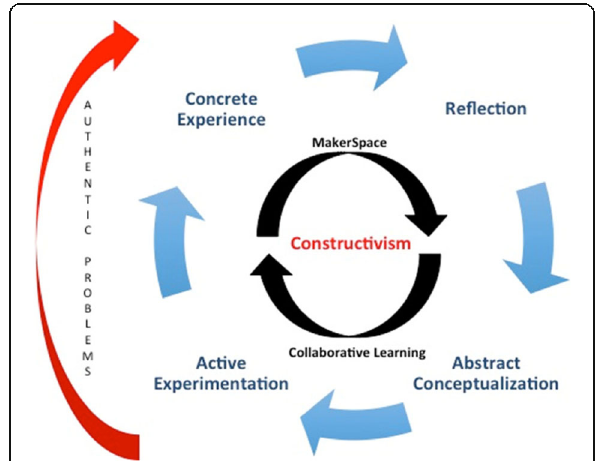
Fig. 1 A conceptual model of the relationship between the instructional theory, instructional strategies, and instructional framework for the course that led to the research of assessment of students ’ perceptions of achieving the course objectives